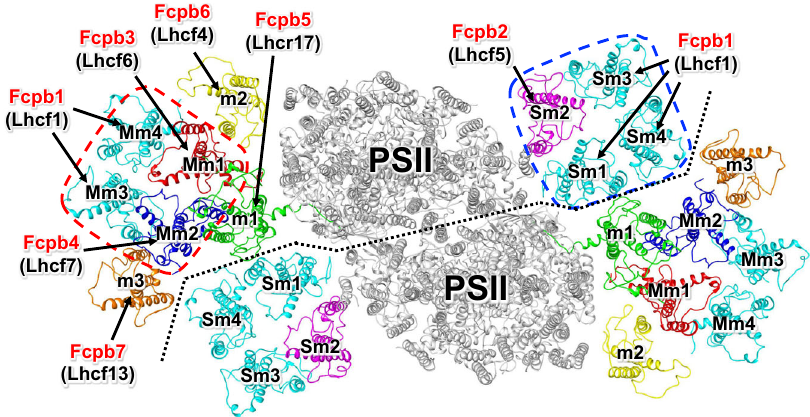
Fig. 1 Overall structure of the PSII-FCPII supercomplex. Overall structure of the PSII-FCPII supercomplex viewed from the stromal side. PSII cores are colored gray, whereas FCPII is labeled and colored differently. Each FCP subunit is annotated as Fcpb1 – 7 (red) with their gene products indicated in parentheses (black). Blue and red dashed boxes indicate S and M-tetramers, respectively. Black dotted line stands for the interface between the two PSII- FCPII monomer